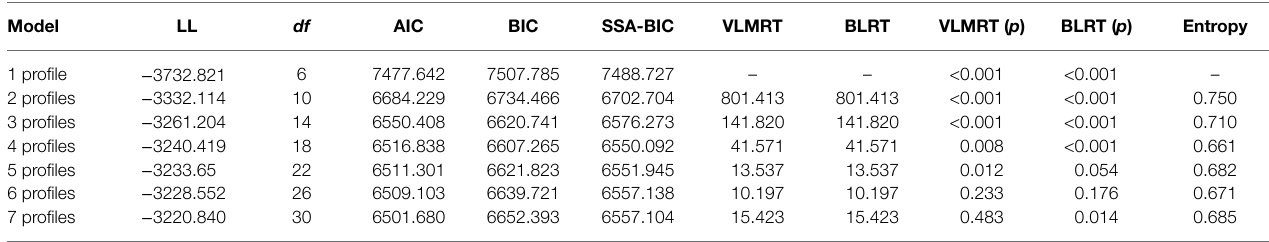
TABLE 3 | Comparing model fit for different burnout profiles.